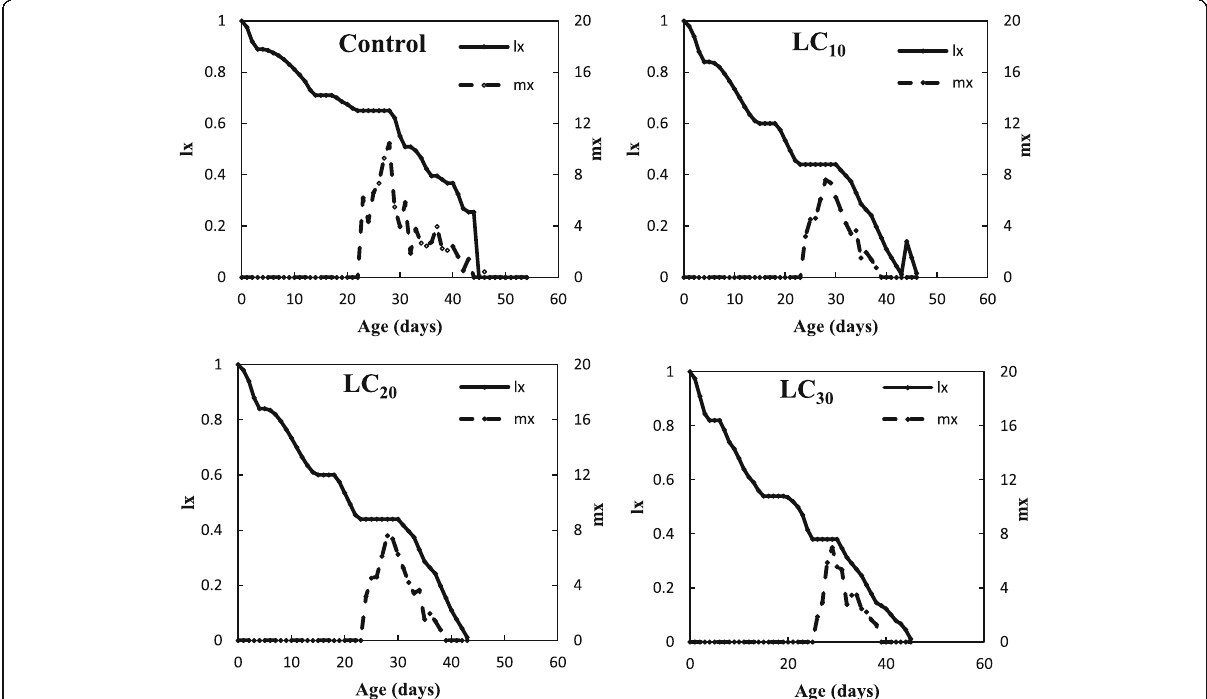
Fig. 2 Age-specific survivorship ( l x ) and fecundity ( m x ) of Tuta absoluta treated with different sub-lethal concentrations of Metarhizium anisopliae (DEMI 001